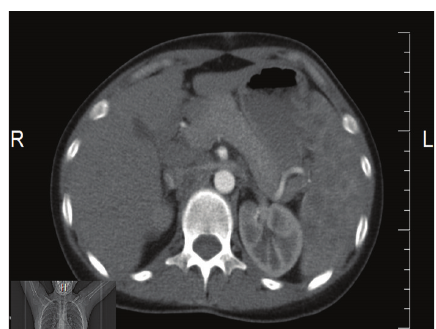
Figure 3: Thoracic CT views.